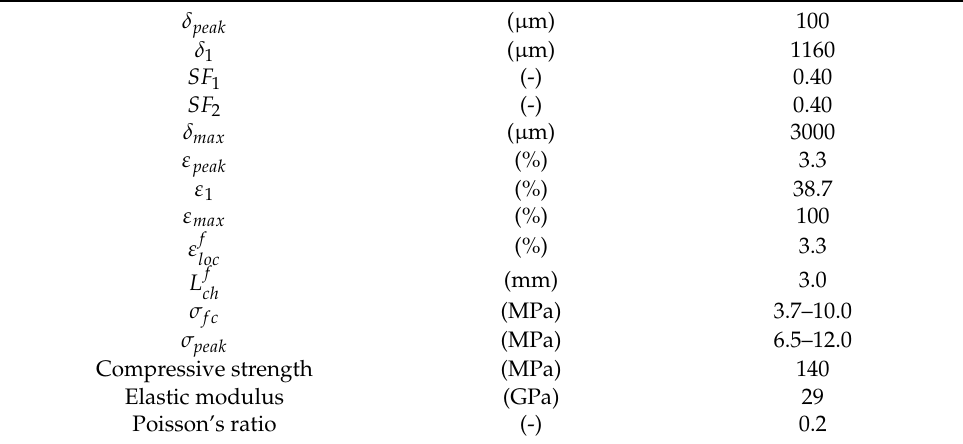
Table 1. Material parameters defining the constitutive law of